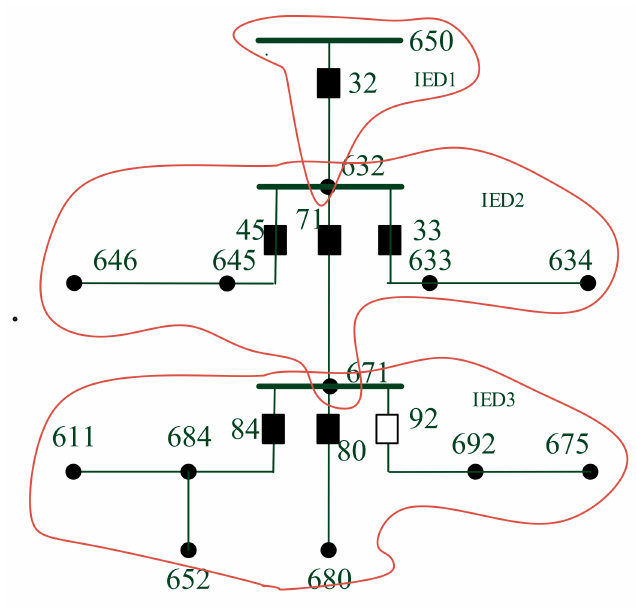
Figure 5. IEEE 13-node feeder and